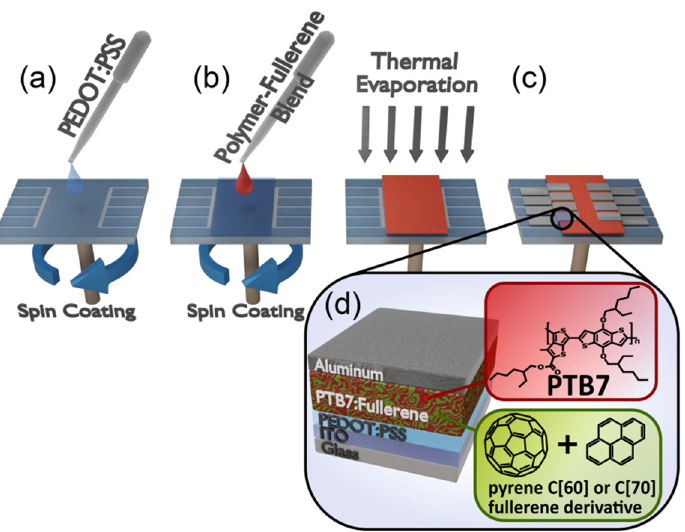
Figure 11. Solar cells preparation scheme ( a ) PEDOT:PSS solution is dynamically spin-coated onto ITO substrate to form an uniform coating layer, ( b ) Active layer solution is likewise spin-coated, ( c ) aluminum cathode is sputtered through mask to obtain 8 separated pixels, ( d ) final structure. The reference PTB7:PC60BM and PTB7:PC70BM blends, both in 2:3 weight ratio, were dissolved in chlorobenzene (CB) or in carbon disulfide (CS 2 ). Blends of PTB7 with